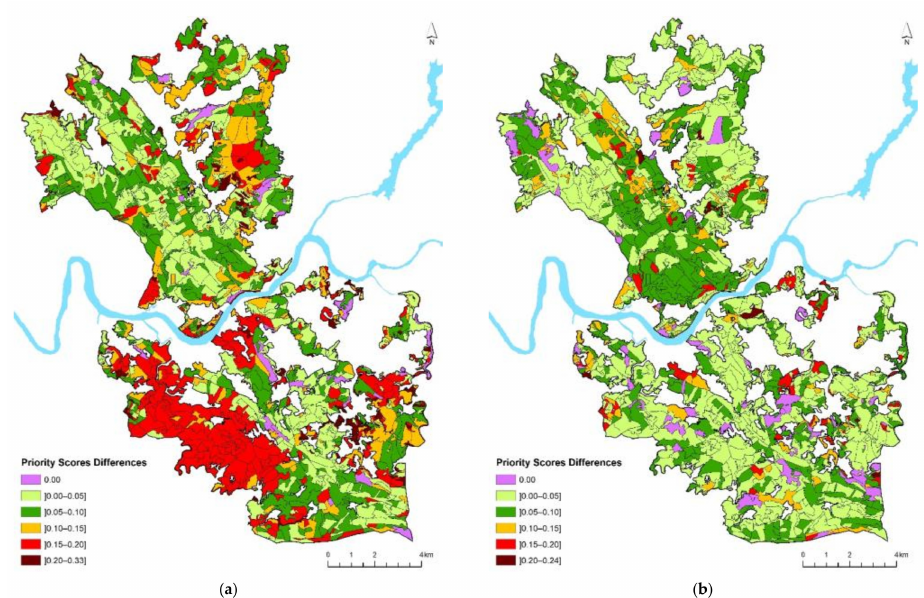
Figure 8. Most meaningful differences in priority scores of the allocation of the ecosystem services to the management units between the most significant group pairs: ( a ) the most discordant groups, with the most significant differences—civil society and market agents; ( b ) the most concordant groups, with minor differences—forest owners and public